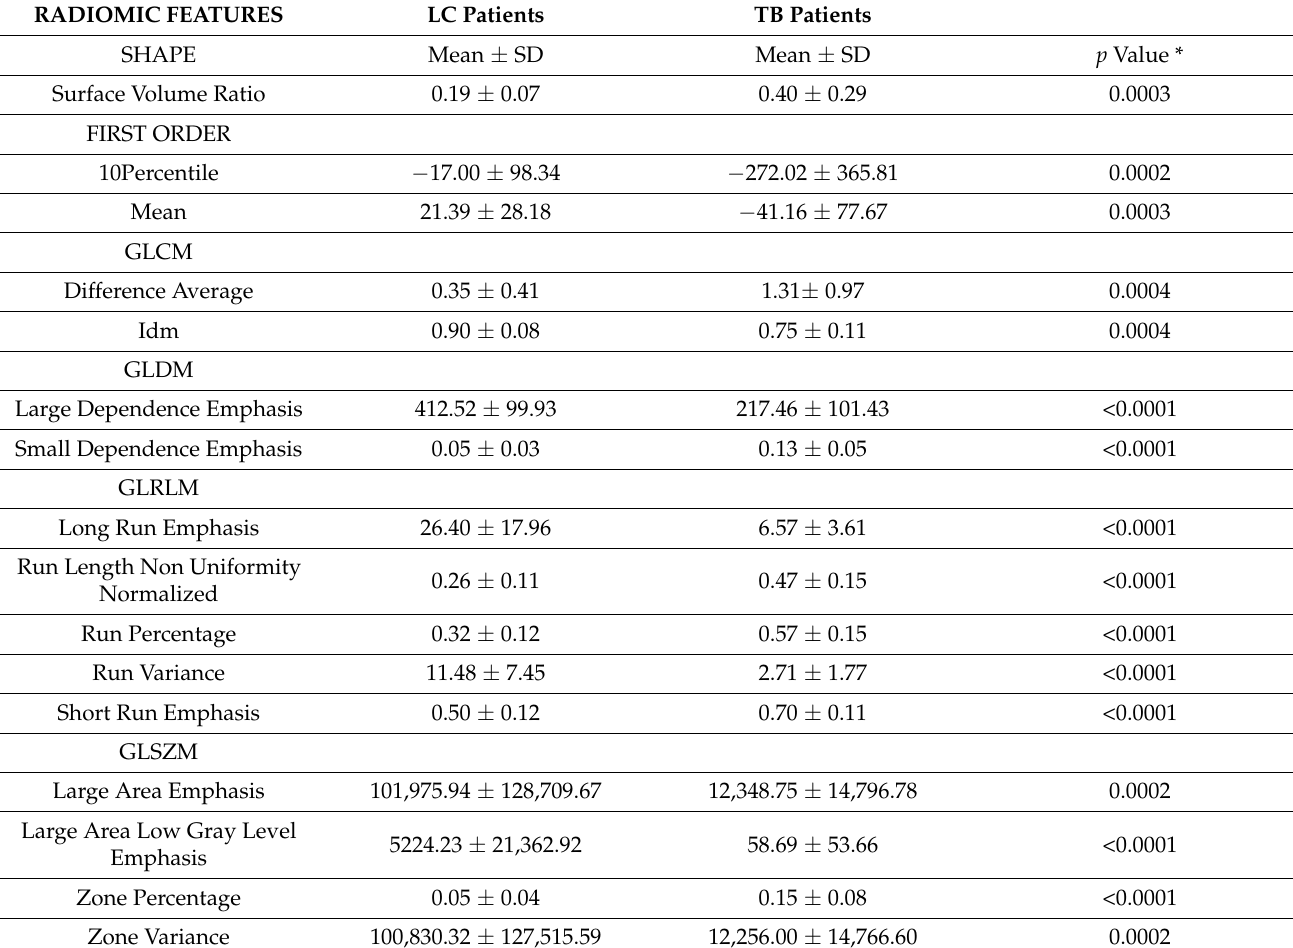
Table 2. Radiomic features. * Holm–Bonferroni